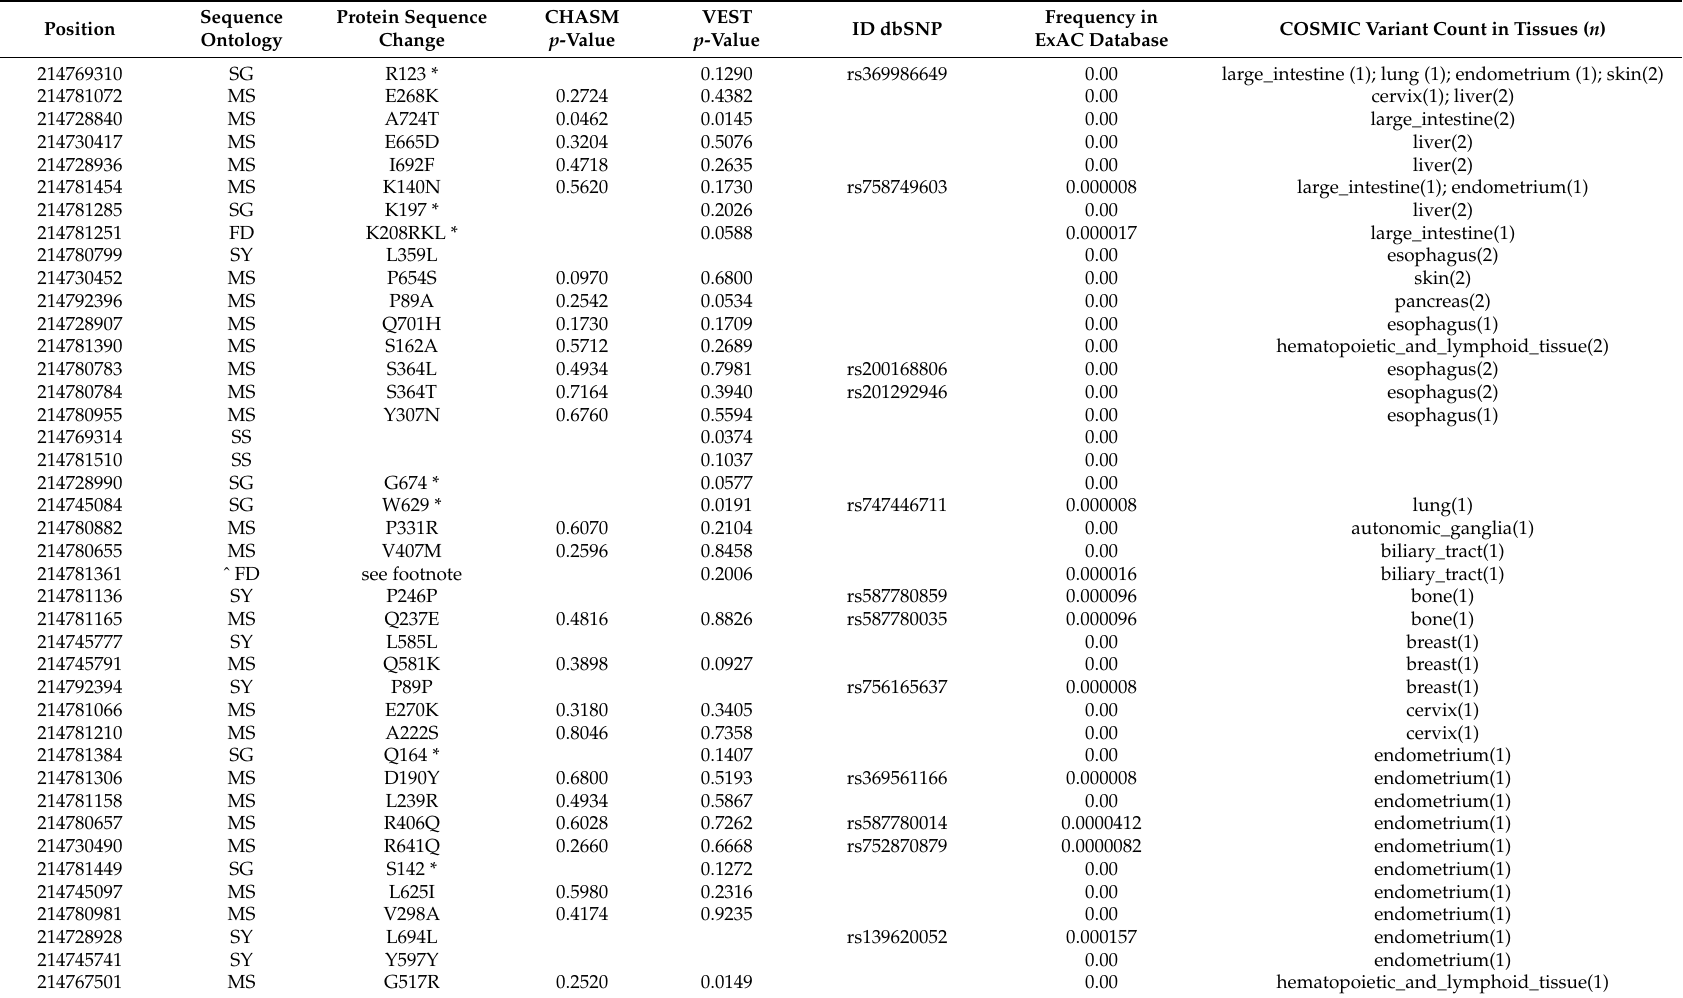
Table 2. Somatic mutations of BARD1 deposited in COSMIC database with pathogenicity statistical